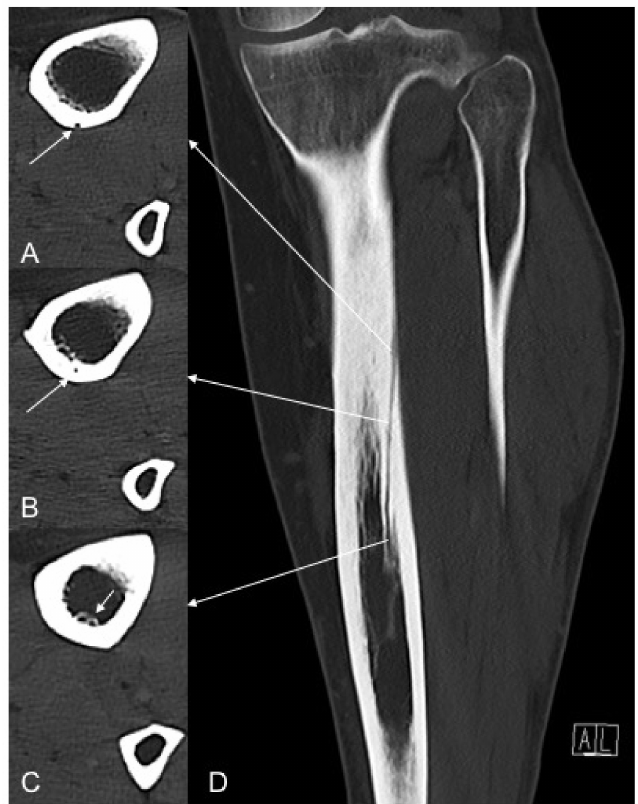
Figure 2. Subsequent axial ( A – C ) and coronal ( D ) reformatted images in bone window indicating the foramen of the nutrient artery canal on the outer cortex ( A ) (white arrows), cortical canal course ( B ) and inner cortex ( C ) (white